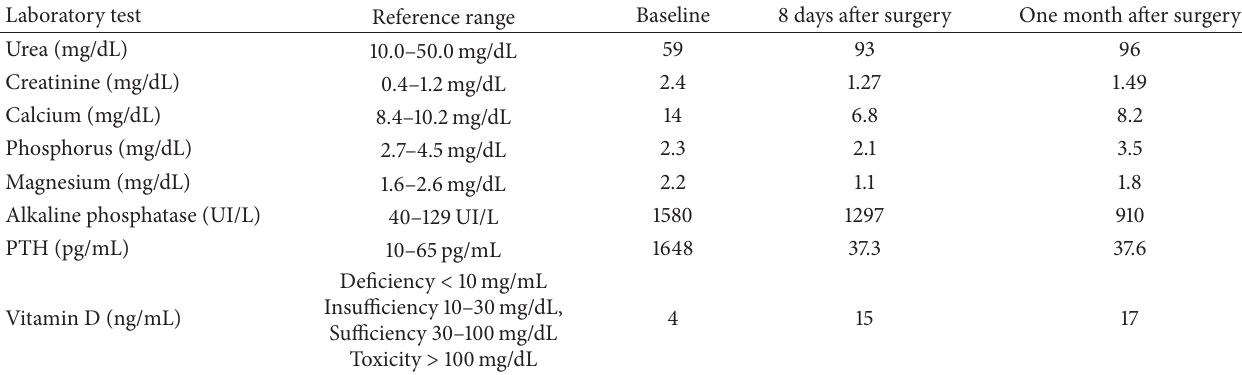
Table 1: Laboratory test at hospitalization and follow-up after